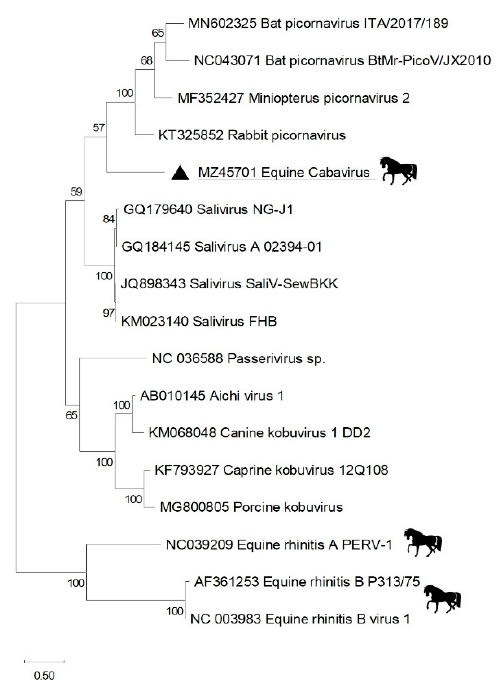
Figure 2. Phylogenetic analysis of RdRp (3CDpol) protein region of novel equine cabavirus picor- navirus. The amino acid phylogenetic tree was constructed using the maximum likelihood method with two substitution models: Le Gascuel 2008 model based with gamma distributed, invariant sites (G + I) for 3CD in MEGA software version X. Viral taxon from this study is highlighted with triangle.